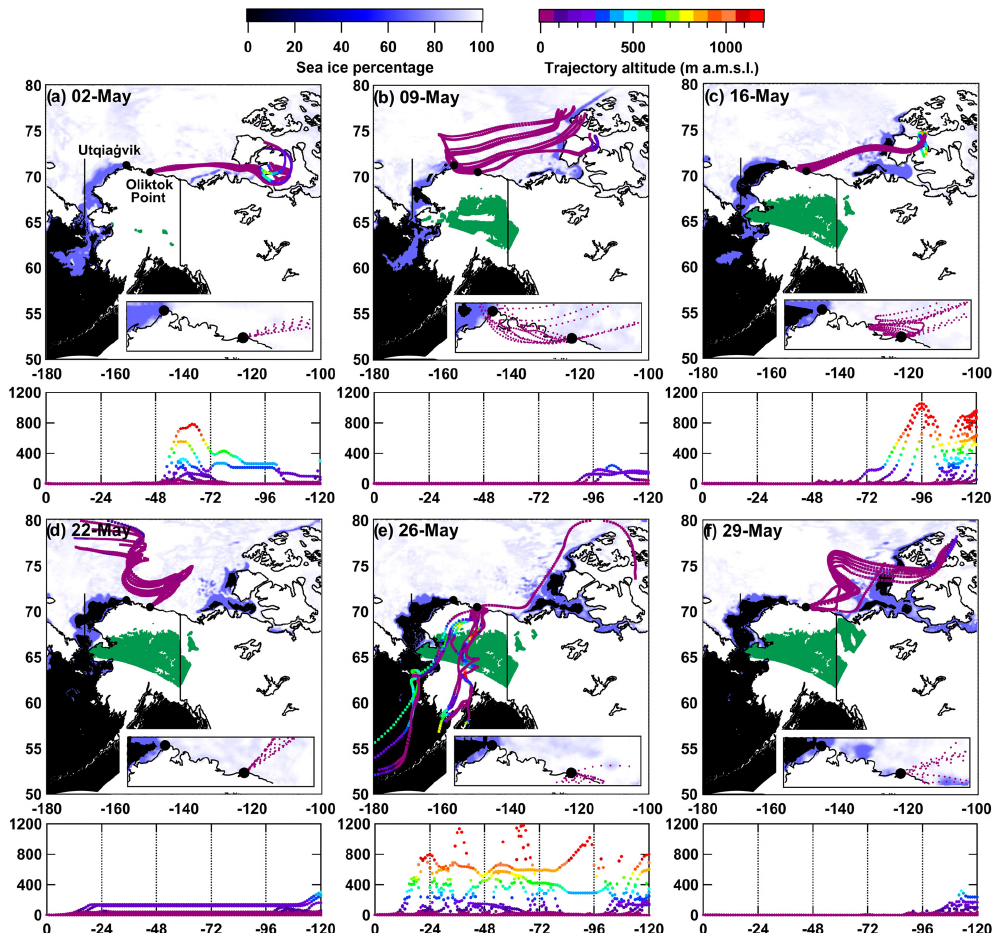
Figure 6. 5-day air mass backward trajectories initiated every 3h and land cover (e.g., sea ice, snow, ocean, and open land) for some of the case days in May with INP data. Each date contains the map and corresponding time–height cross section of the 5-day trajectories (shown below each map). The x and y axes for the maps represent degrees longitude and latitude, respectively, while those axes for the time–height cross sections represent the hours before reaching Oliktok Point and altitude (ma.m.s.l.), respectively. The locations of Utqia˙gvik and Oliktok Point are labeled in (a) but indicated in all panels by the black circles. On land, white indicates snow-covered surfaces while green indicates open land (e.g., tundra). Land data are missing in southern Alaska and most of